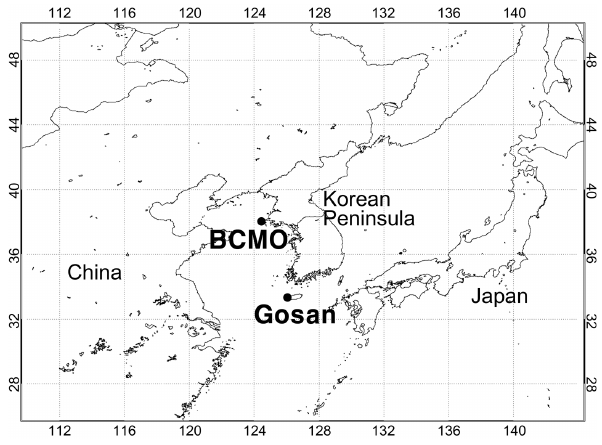
Fig. 1. Locations of the measurement sites, Gosan and BCMO (Baengnyeongdo Comprehensive Monitoring Observatory).